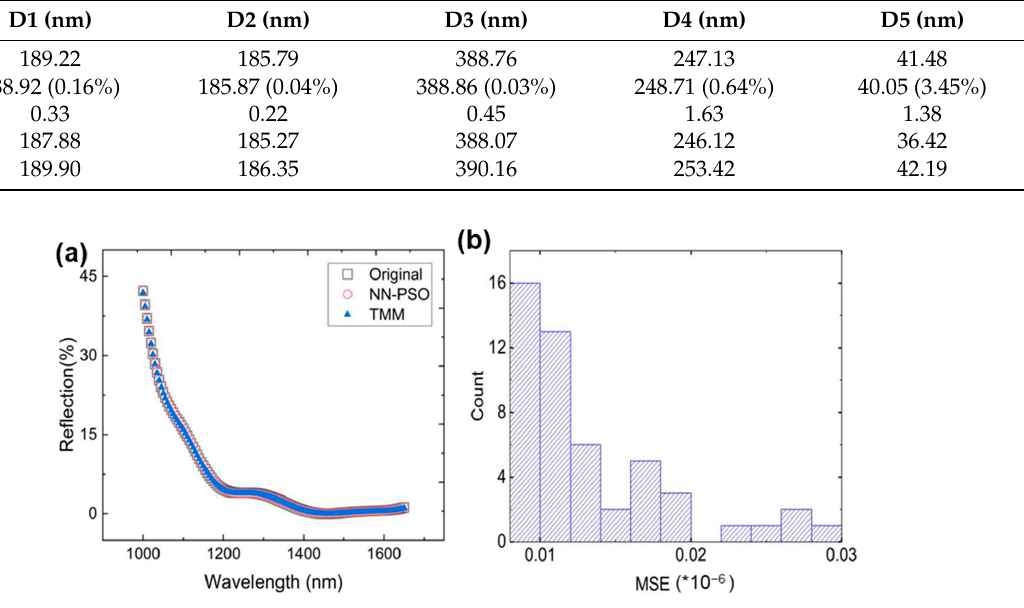
Figure 4. ( a ) Reflection spectrum verification and ( b ) the MSE distribution histogram of NN-PSO predicted spectra. predicted spectra.